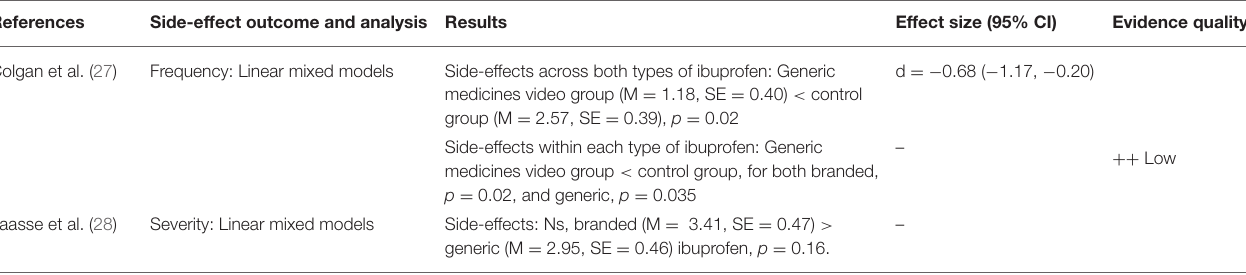
TABLE 4 | Branding intervention